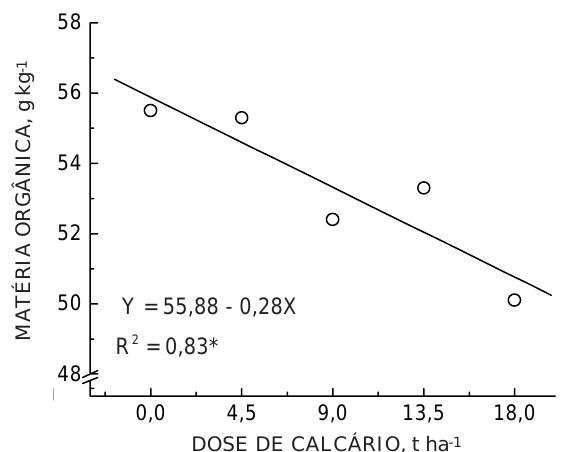
Figura 2. Teores de matéria orgânica na camada de 0-10 cm, considerando as doses de calcário aplicadas num Latossolo Bruno. * Significativo a 5%.